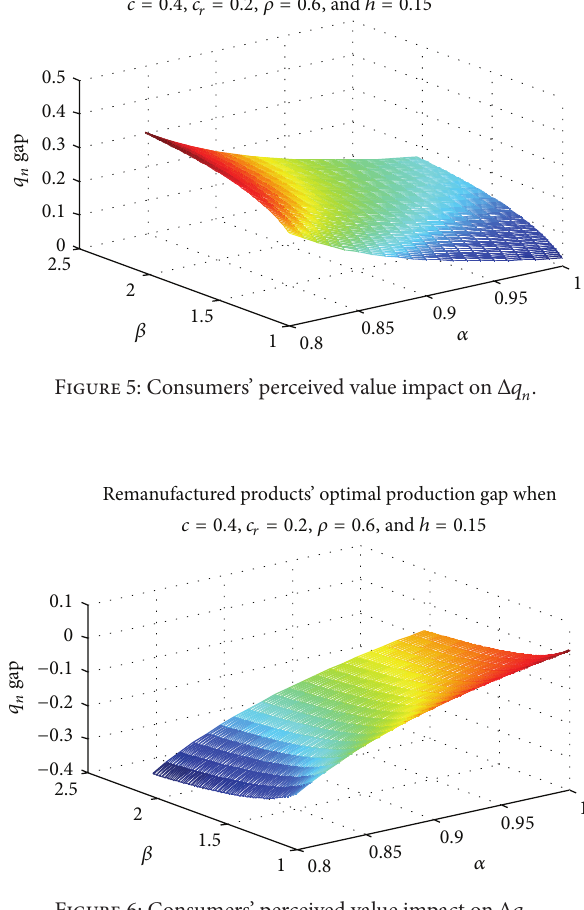
Figure 6: Consumers’ perceived value impact on Δ𝑞 𝑟